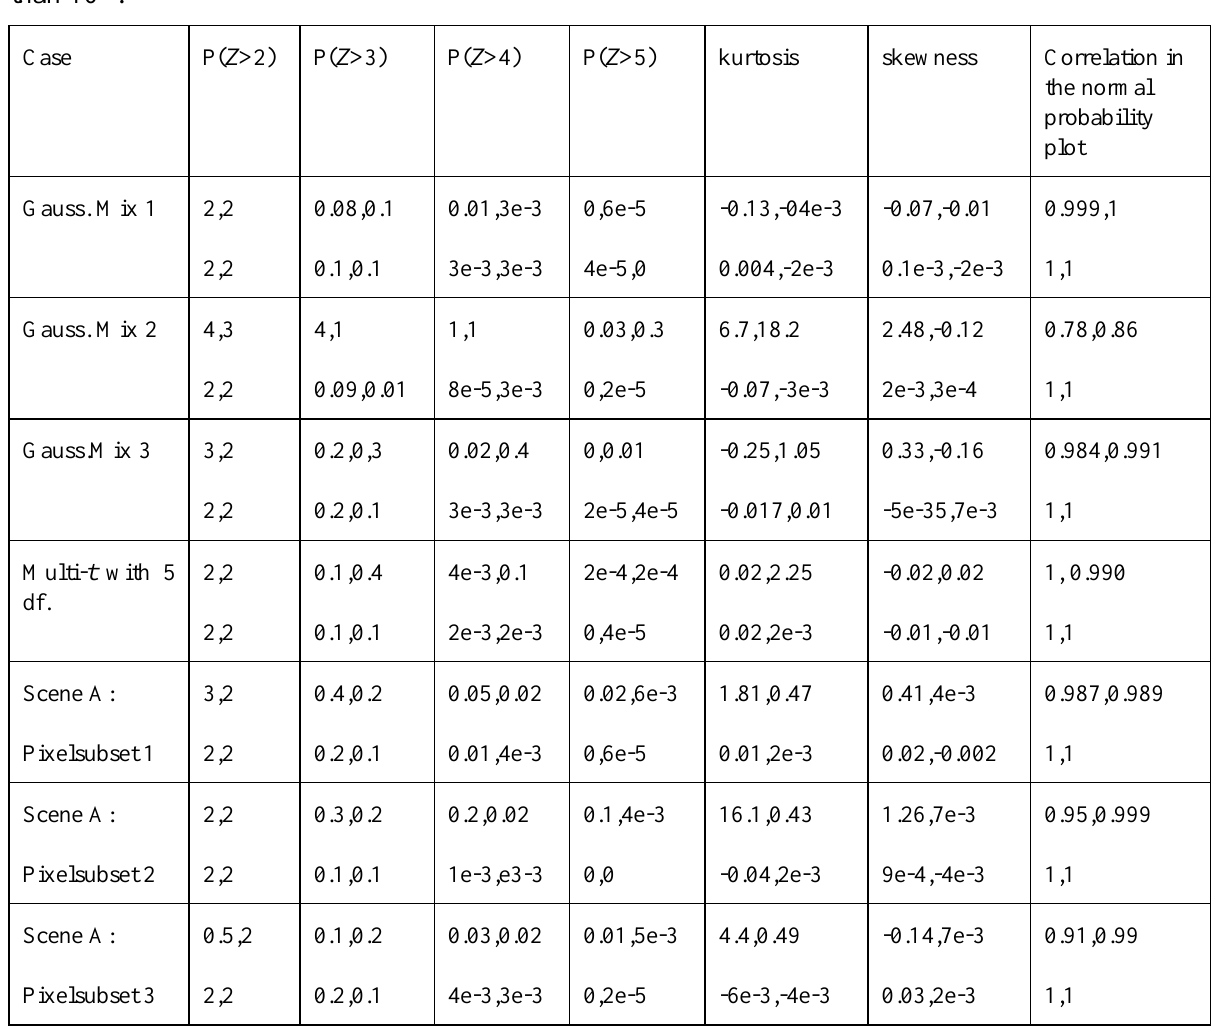
Table 1 . Cell entries in columns 1 to 4 are 100 times the fraction of (CLS,GLS) values (averaged over 296 chemicals, each scaled-to-unit-variance), denoted Z , that exceed 2, 3, 4, or 5, and the kurtosis, skewness, and correlation in the normal probability plot. These (CLS, GLS) entries are given twice per cell: once for the scene and once for a corresponding simulated Gaussian reference scene. Entries for the 100 times the fractions exceeding thresholds are within approximately in hypothetical repeats of the same procedure. Entries for skewness and kurtosis are